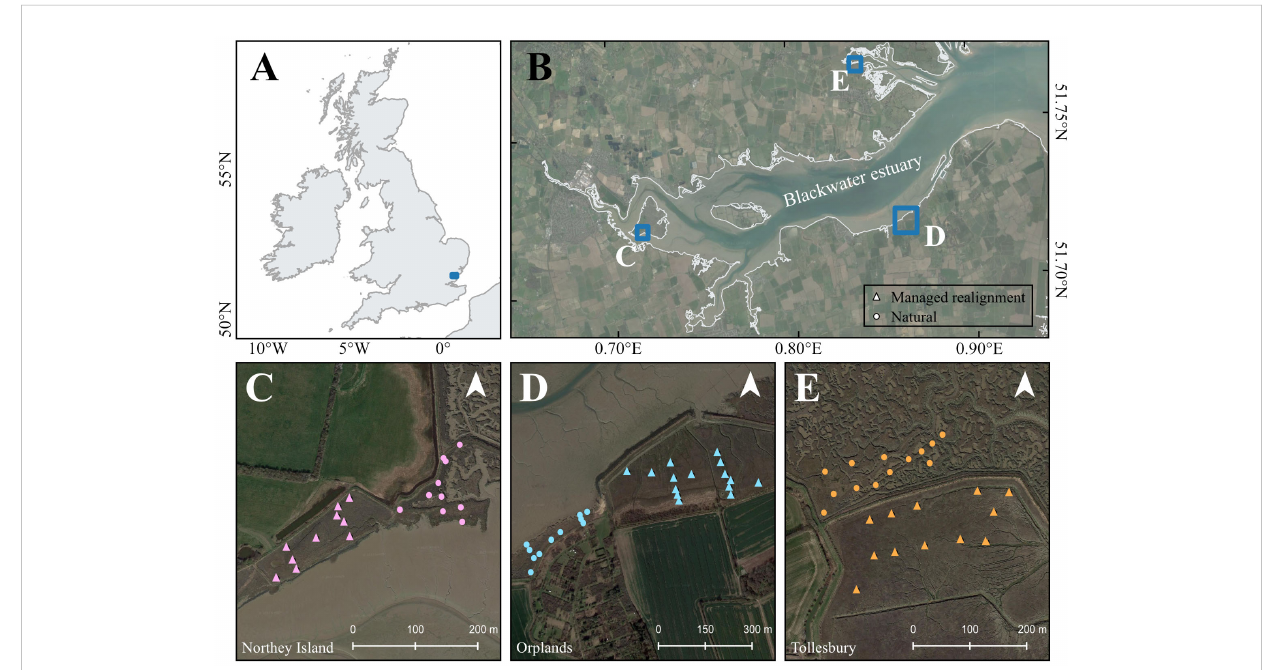
FIGURE 1 Location of Blackwater Estuary, Essex within southeastern England (A) and saltmarsh study sites within the Blackwater Estuary (B) . Sampling transects and plot locations are shown for managed realigned (triangle) and natural (circle) sites at Northey Island (C) , Orplands (D) , and Tollesbury (E)